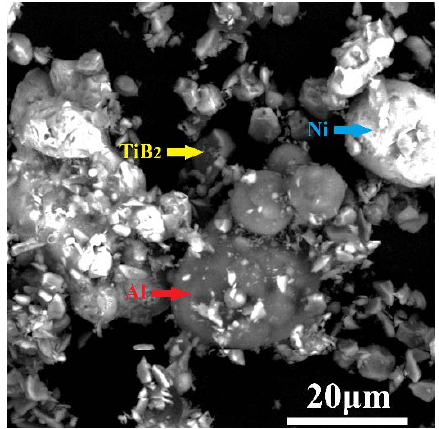
Figure 2. The morphology of Ni-Al/TiB 2 powders.